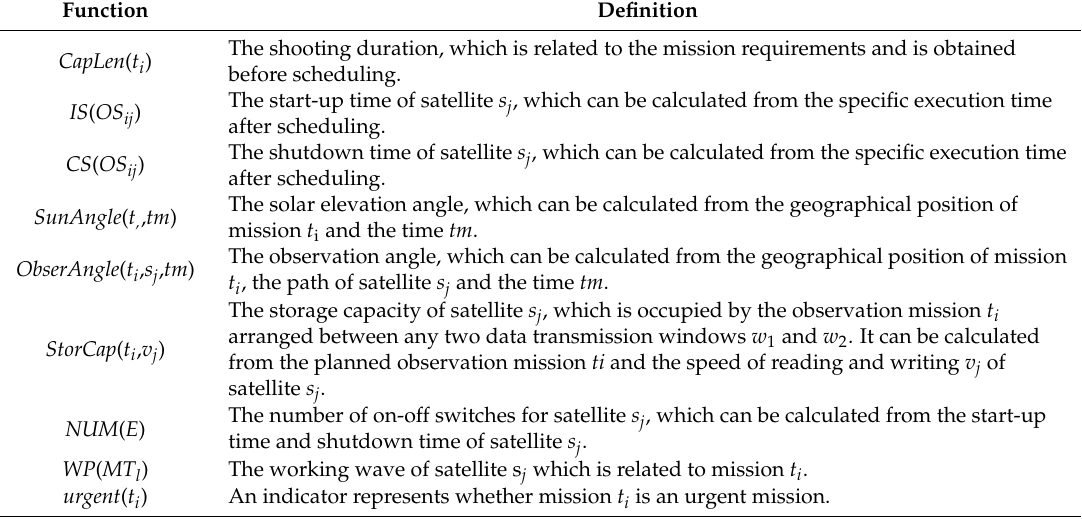
Table 3. Function definitions in the